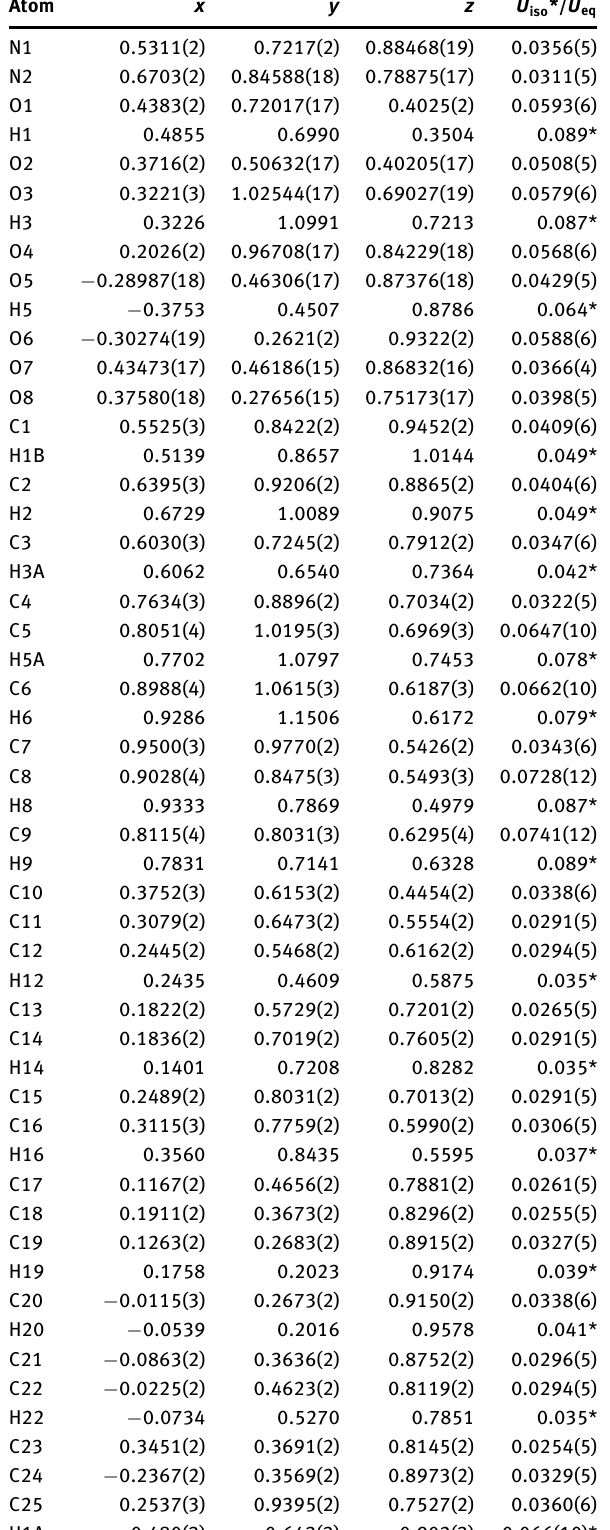
Table 2: Fractional atomic coordinates and isotropic or equivalent isotropic displacement parameters (Å 2